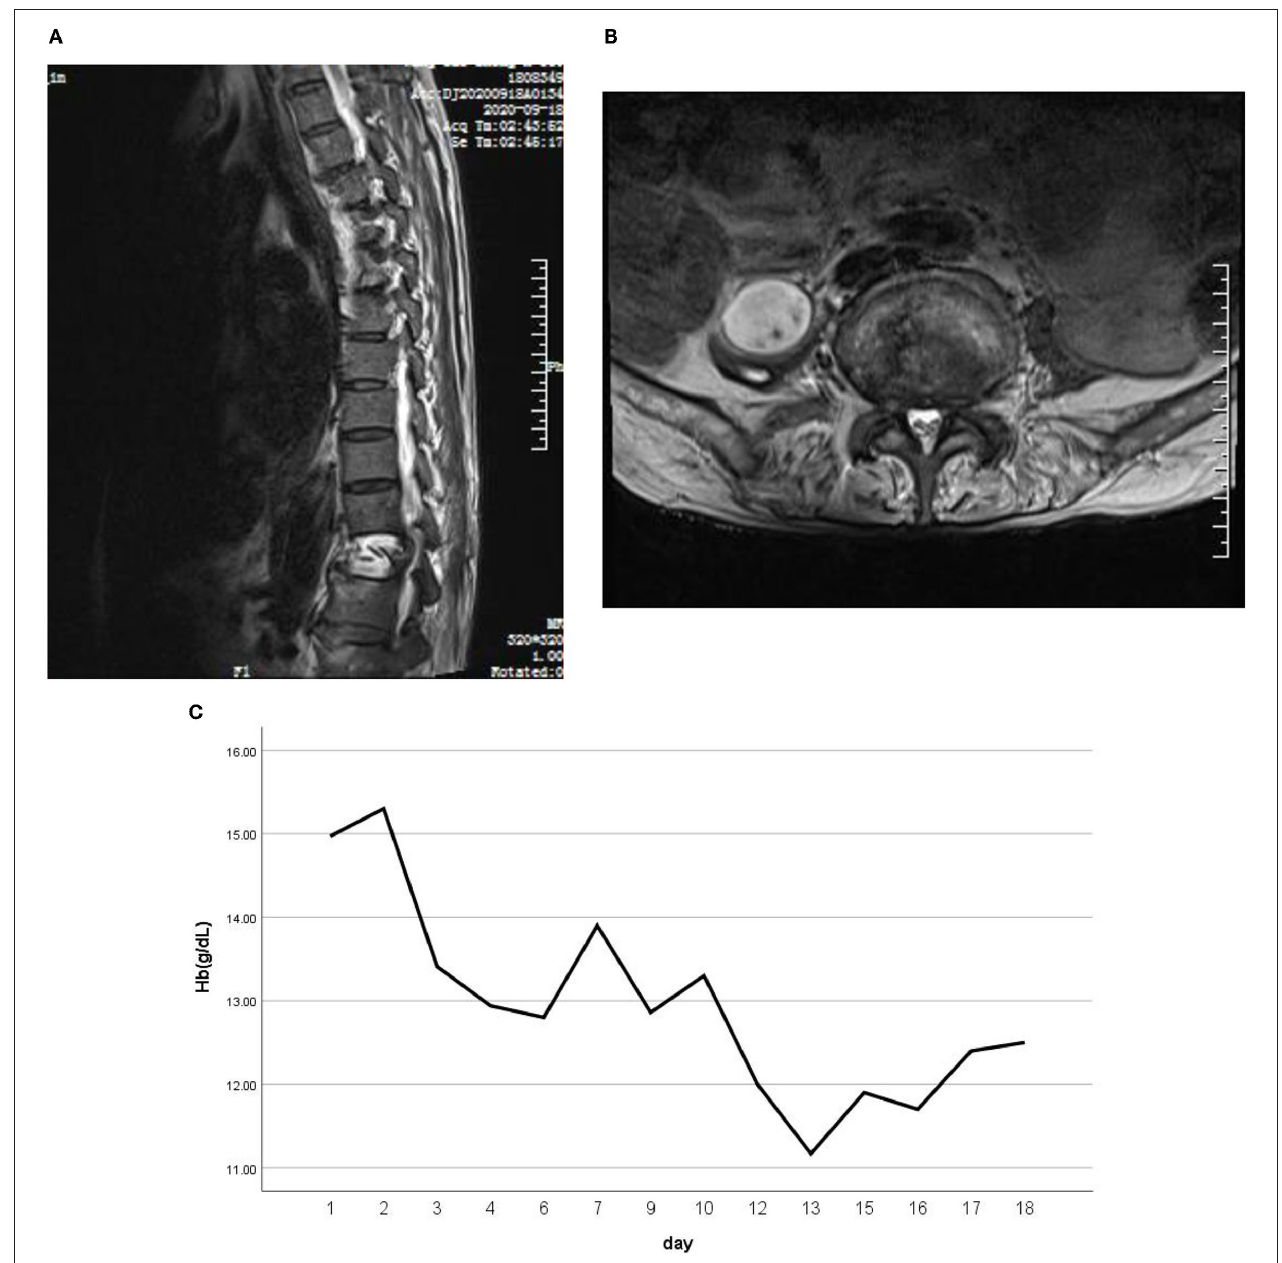
FIGURE 2 | Lumbar MRI showed an oval-shaped confined mass in the right-side psoas major muscle (A) . (B) T4/5/7/12 compression fractures. (C) A blood routine test suggested progressive anemia.